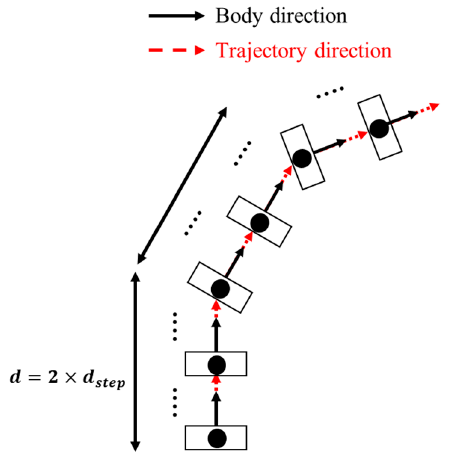
Figure 6. Illustration of direction changes.